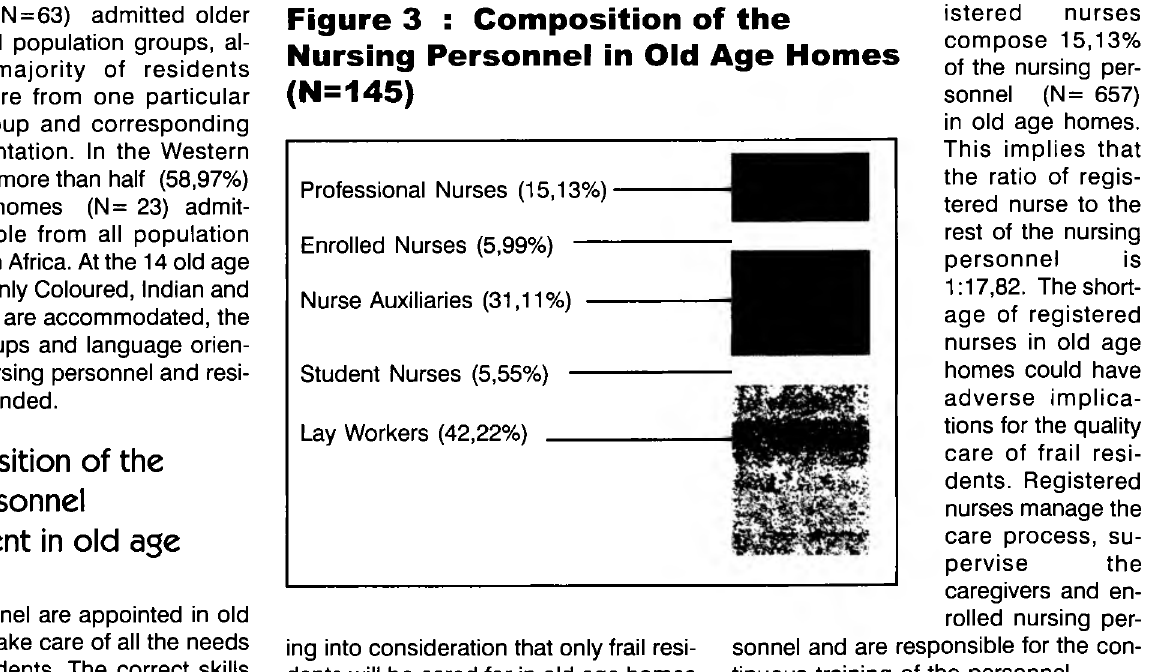
Figure 3 : Composition of